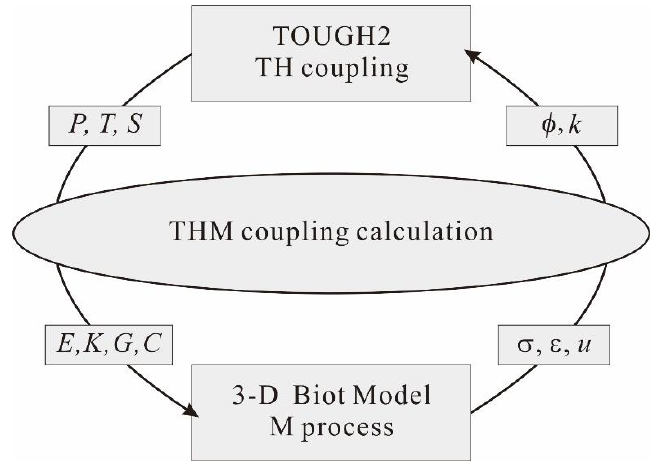
Figure 5. Coupling methods used for the thermo-hydro-mechanical processes.